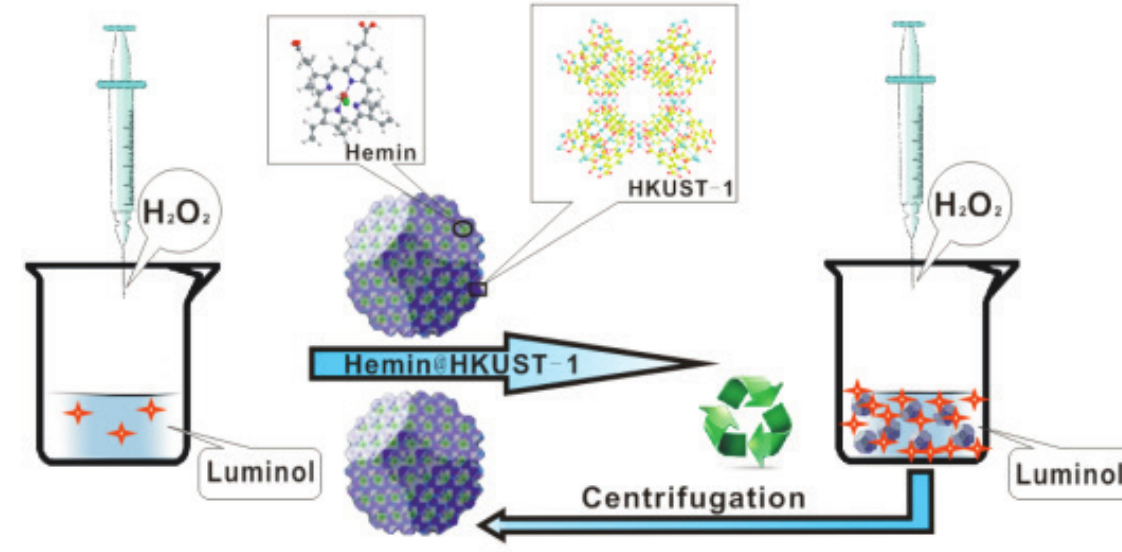
Figure 16: Mechanism of chemiluminescence observed from haemin-catalysed oxidation of luminol by H